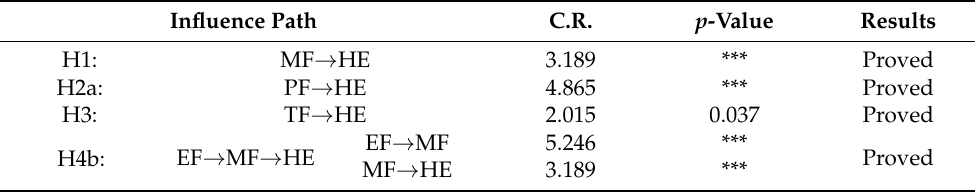
Table 7. The response hypothesis testing results of C.R. value, significance